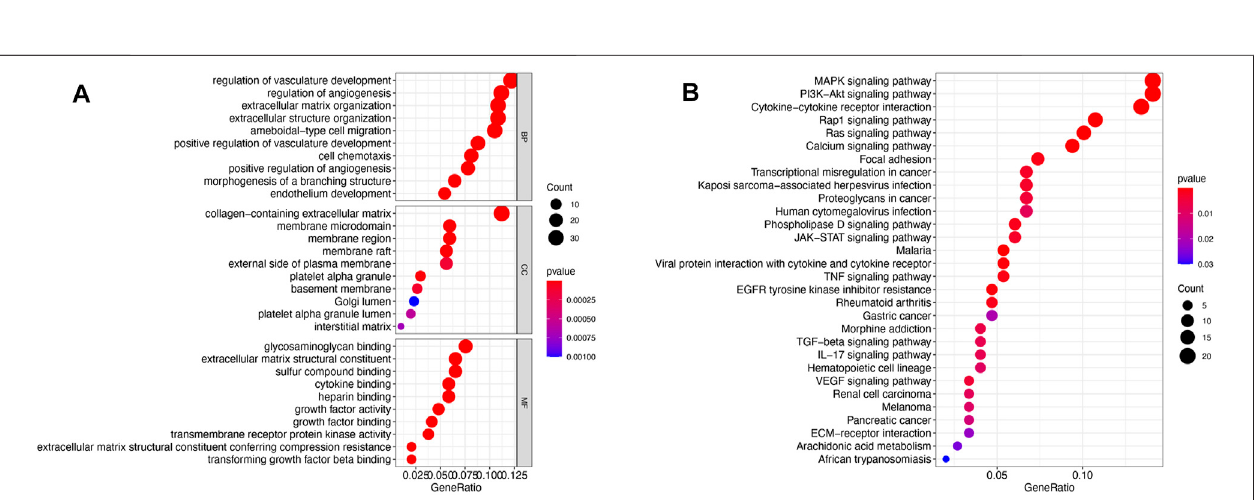
FIGURE 3 | Functional enrichment of the yellow module. (A) Bubble plots of the results of GO enrichment analysis. The top 10 terms in the BP, CC, and MF categories with regard to the number of enriched genes in the yellow module as determined by GO analysis are shown. (B) Bubble plots of the KEGG pathways for the yellow